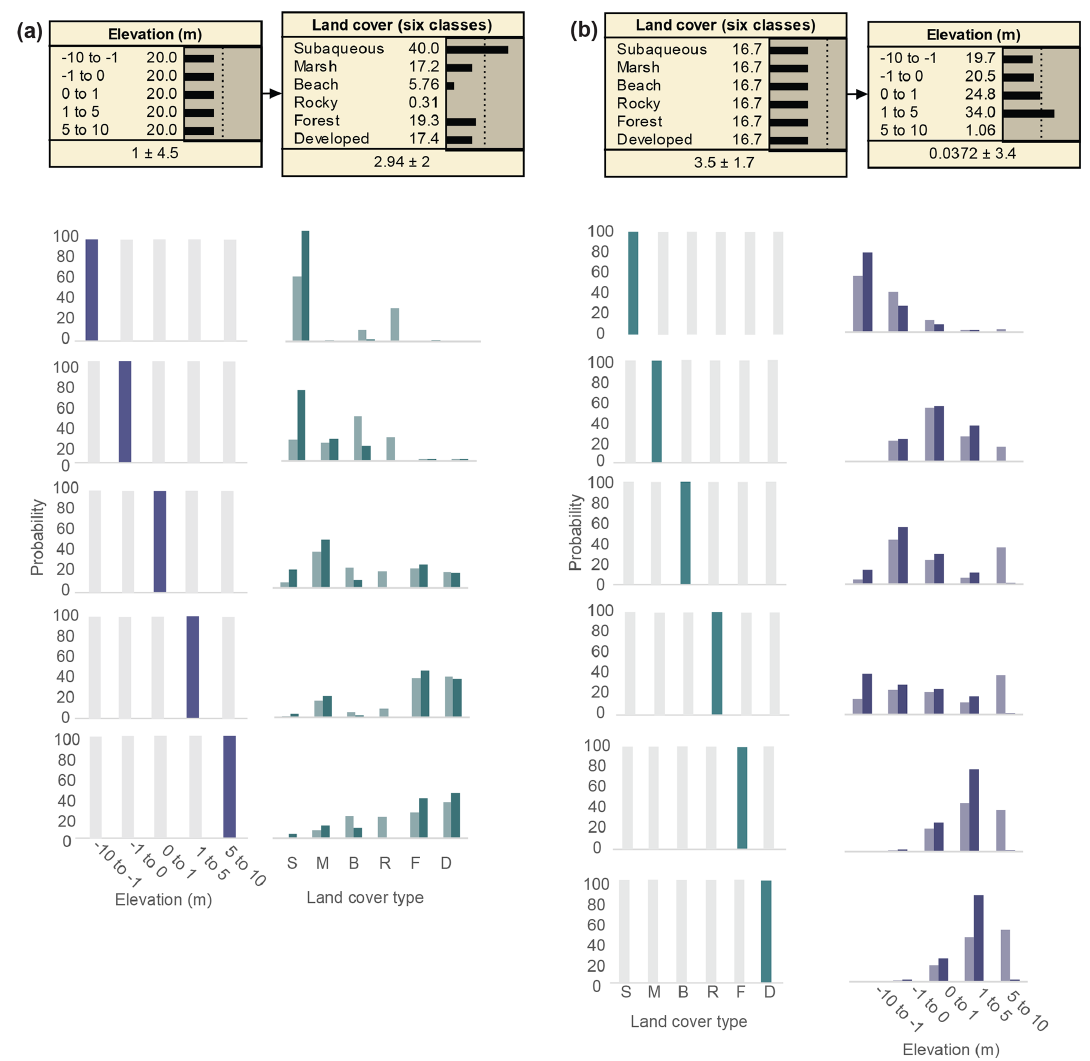
Figure 1. Updated probability distributions after training between elevation and land cover datasets with nonuniform (dark) and uniform (light) priors (the latter to limit regional LC bias), (a) showing land cover distributions under selected elevation ranges and (b) elevation distributions under selected land cover types. Land cover categories (Table S1) are abbreviated as follows: S – subaqueous; M – marsh; B – beach; R – rocky; F – forest; and D –